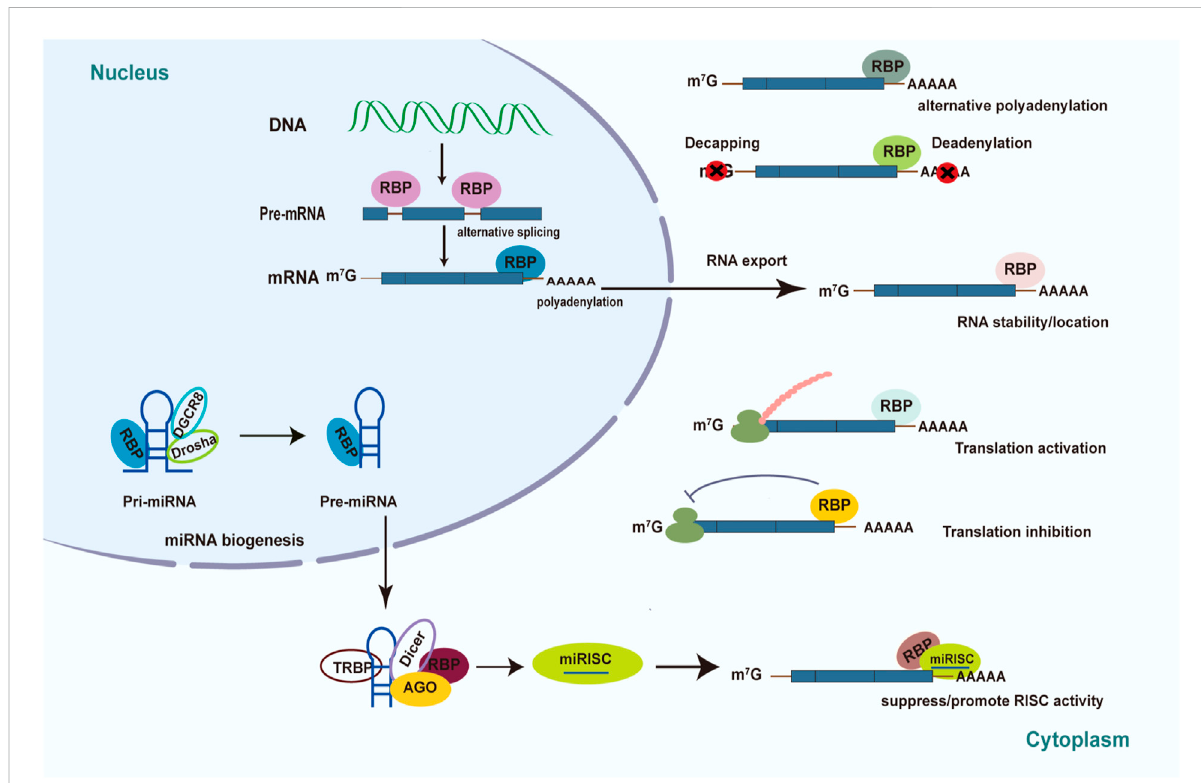
FIGURE 1 Mechanismofposttranscriptionalregulationcontrolled byRBPsindiabetes. Schematicdiagramssummarizethevarious rolesofRBPsplayedin diabetes pathology and diabetic complications. RBPs have the ability to determine RNA ’ s fate through pre-mRNA splicing, translational control, polyadenylation, RNA stability, RNA localization, RNA export, and miRNA-mediated